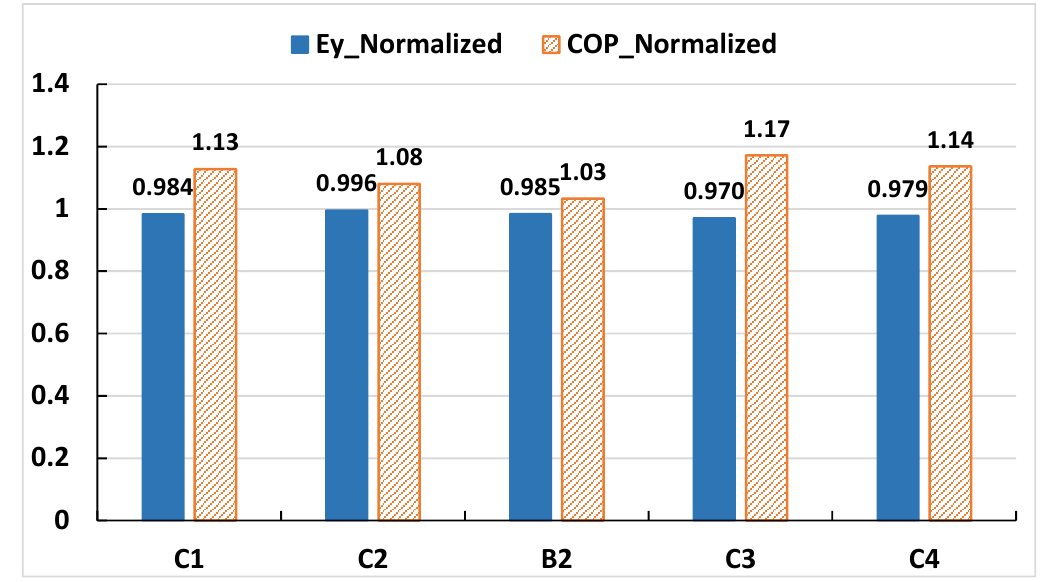
. Figure 10. Values of 〈𝐸̇ 𝑦 〉 𝑡 and Coefficient of Performance (COP) normalized with respect to values E y (cid:105) t and Coe ffi cient of Performance (COP) normalized with respect to values of Figure 10. Values of (cid:104) of case B1 (ΔT = 2.42 K) for different material combinations. case B1 ( ∆ T = 2.42 K) for di ff erent material